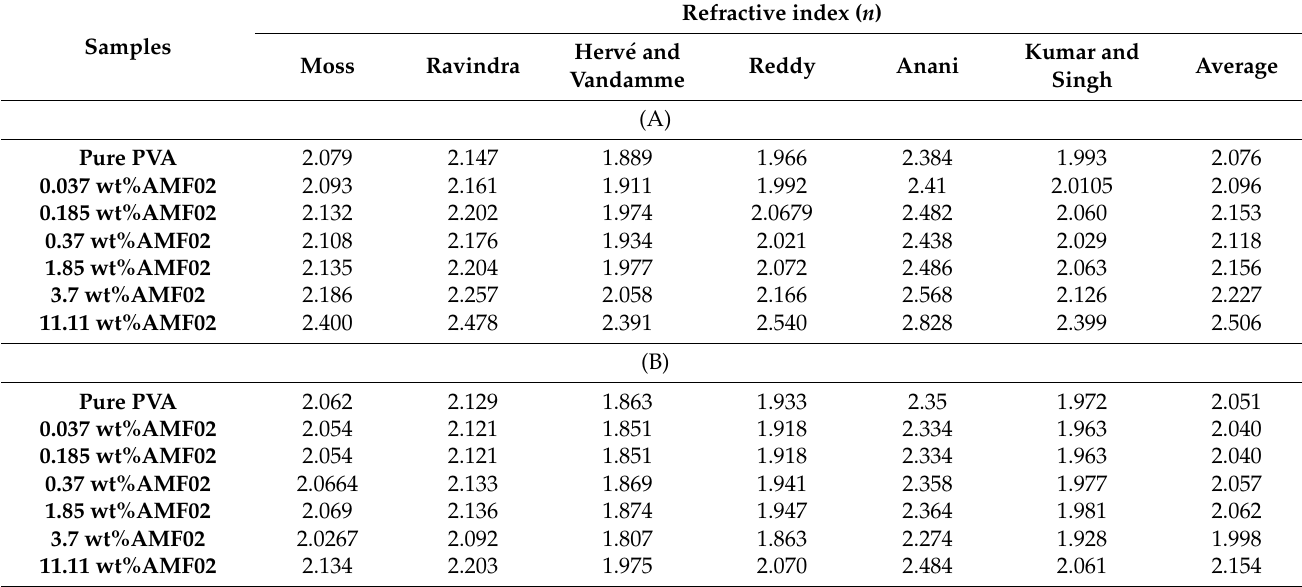
Table 2. The refractive index parameters obtained from the Moss, Ravindra, Herv é and Vandamme, Reddy, Anani, and Kumar–Singh relations, and the average refractive index value for the investigated PCCEFs with various AMF02 adding salts. For indirect band